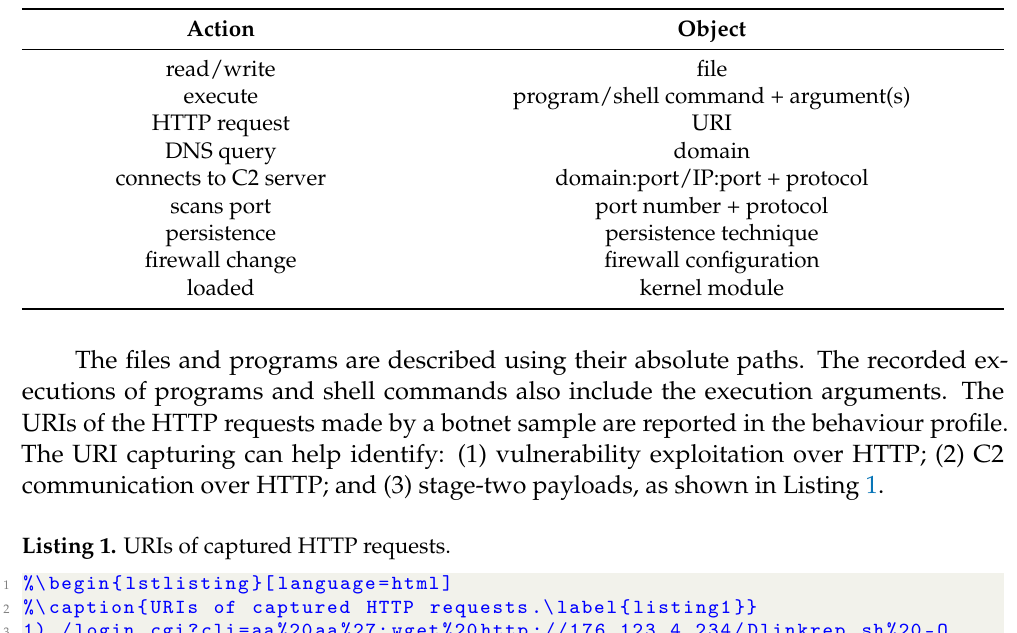
Table 2. Actions comprising the behaviour